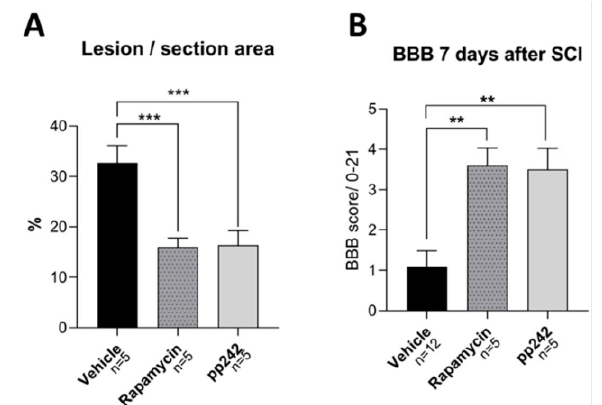
Figure 5. mTOR inhibition caused an improvement in locomotor function and a reduction in lesion size in acute SCI. A reduction in lesion size ( A ) was observed in the RAPA and pp242 groups. Significantly higher Basso, Beattie, and Bresnahan (BBB) scores ( B ) were observed following the treatment with rapamycin or pp242 after 7 days of SCI. Data are shown as means ± SEM; ** p < 0.01, *** p <